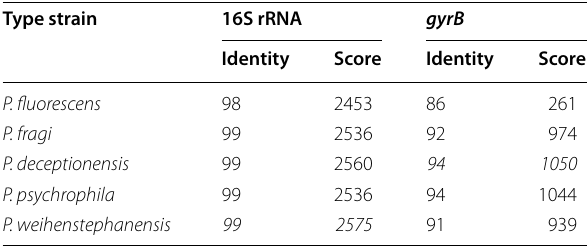
The best hits in the database are highlighted in italics